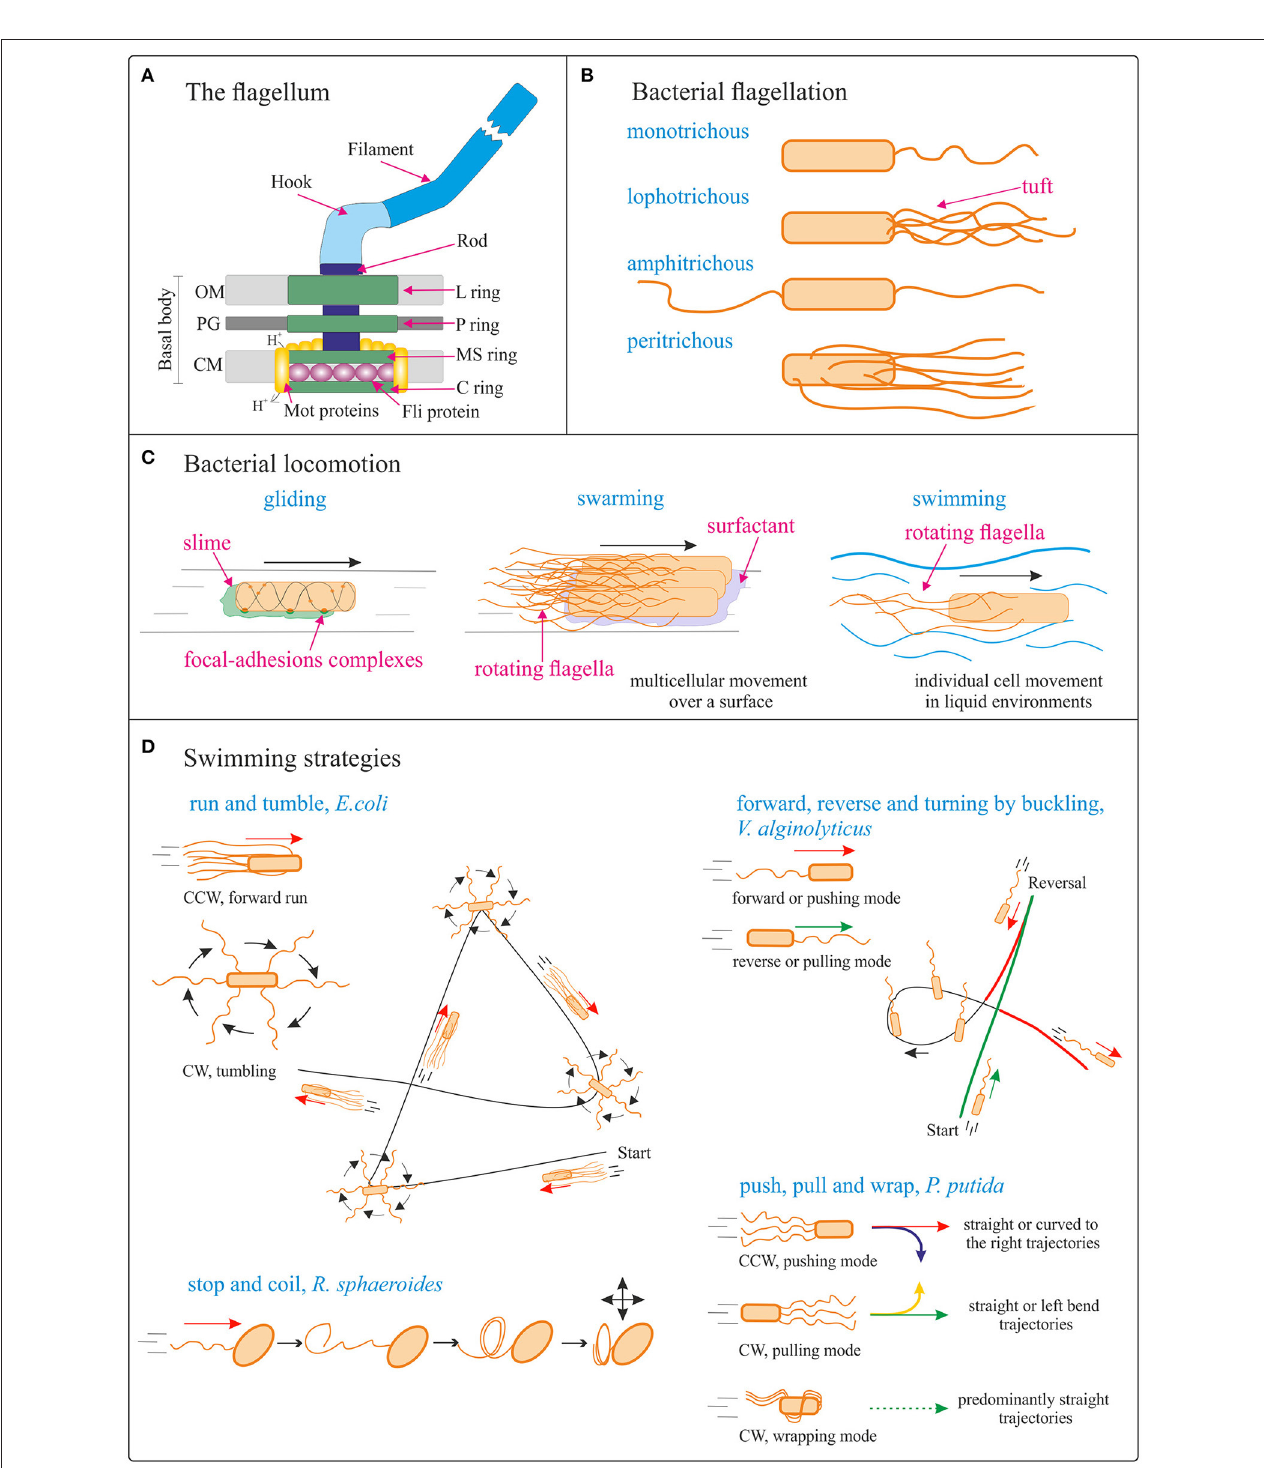
FIGURE 2 | Bacterial locomotion. (A) Schematic (not to scale) structure of the flagellum in Gram-negative bacteria. OM, outer membrane; PG, peptidoglycan cell wall; CM, cytoplasmic membrane. Adapted from Madigan et al. (2014). (B) Different types of bacterial flagellation. (C) Different bacterial locomotion strategies: gliding (focal adhesion model) (adapted from Islam and Mignot, 2015), swarming (adapted from Kearns, 2010), and swimming. The direction of bacteria movement is indicated by black arrows. (D) Schematics (not to scale) of different swimming strategies. Run and tumble from Escherichia coli ; forward, reverse, and turning by buckling of Vibrio alginolyticus (adapted from Son et al., 2013); stop and coil from Rhodobacter sphaeroides (adapted from Armitage and Macnab, 1987; Armitage et al., 1999); push, pull, and wrap from Pseudomonas putida (adapted from Hintsche et al., 2017). The direction of bacteria movement is indicated by the arrows. See main body text for